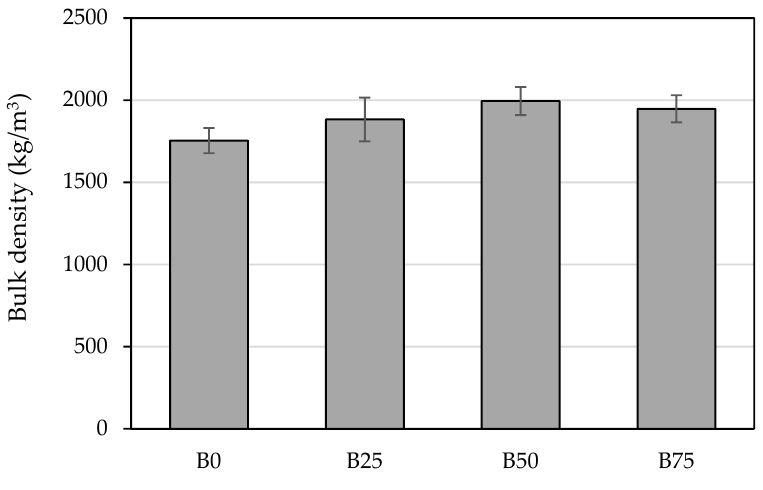
Figure 5. Average bulk density results.